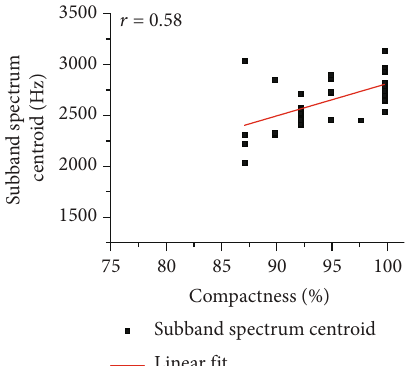
Figure 14: Correlation graphs of soil samples with di ff erent compaction degrees under the action of 85(L) N hammering force and the centroid of sound subband